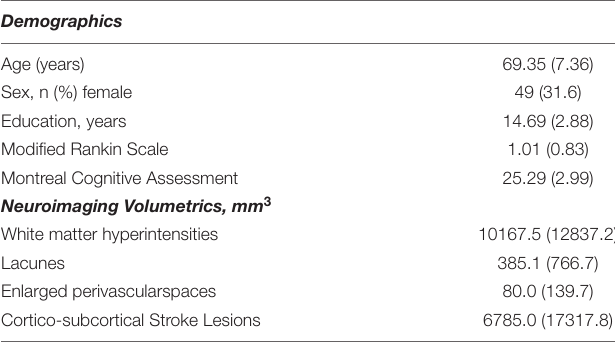
TABLE 1 | Study participant demographics and neuroimaging volumetrics ( n = 155).